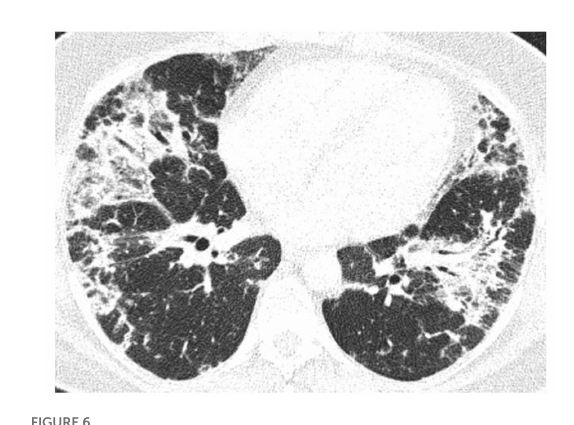
FIGURE 6 HRCT scan. Etanercept induced AFOP, in patient with rheumatic arthritis and pulmonary fibrosis. Bilateral consolidations with air bronchogram, interlobular septa thickening, and ground glass opacities predominated in the peripheral parts of both lungs.